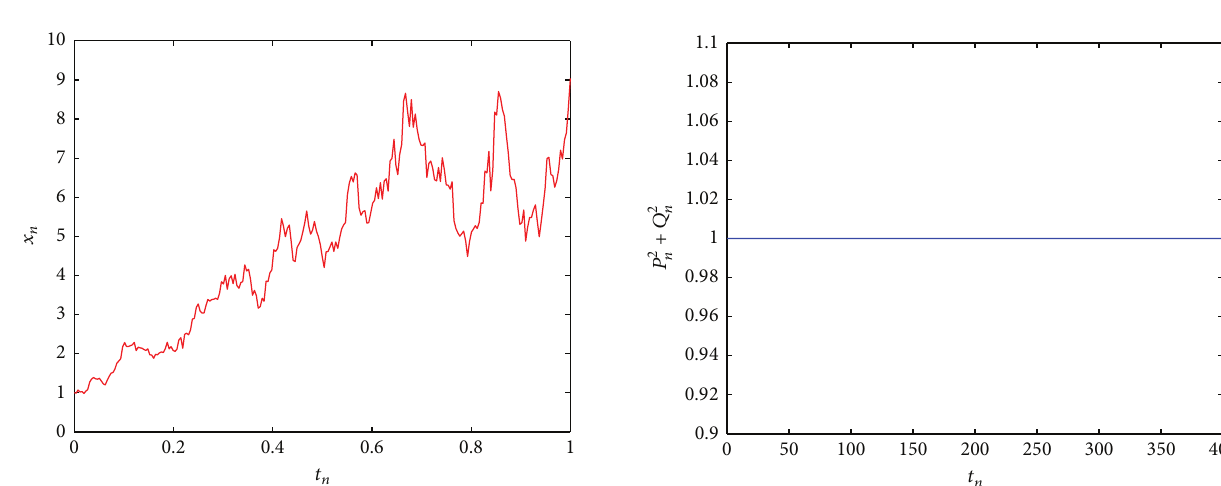
Figure 3: Preservation of first integral 𝛾(𝑝,𝑞) by numerical solu- tions produced by